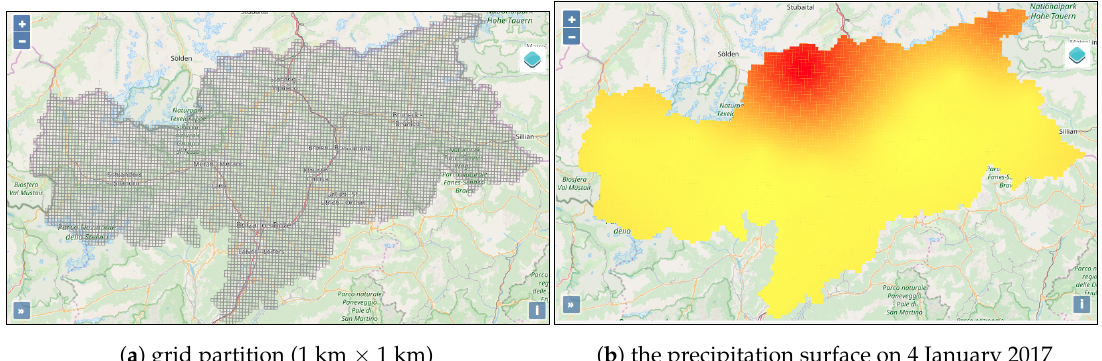
Figure 3. The partition of the study area into grid cells and the interpolation result.